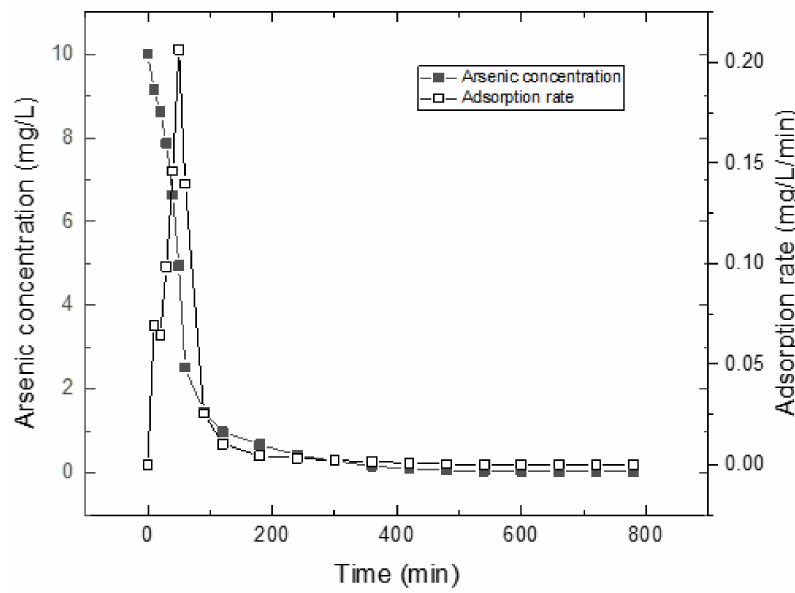
Figure 7. Arsenic removal measured a as a function of